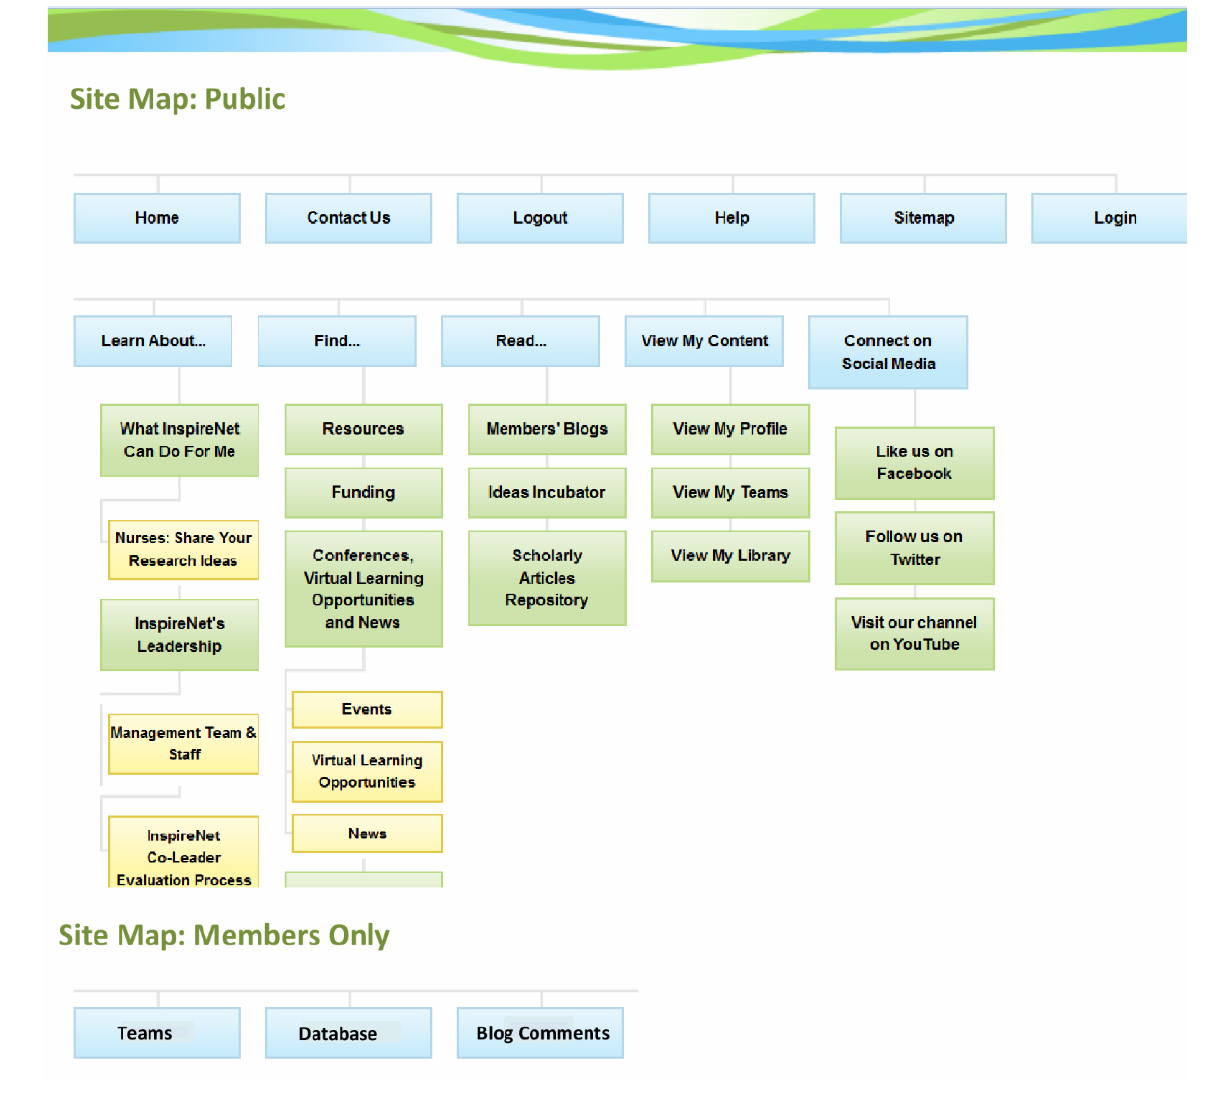
Figure 2. InspireNet site